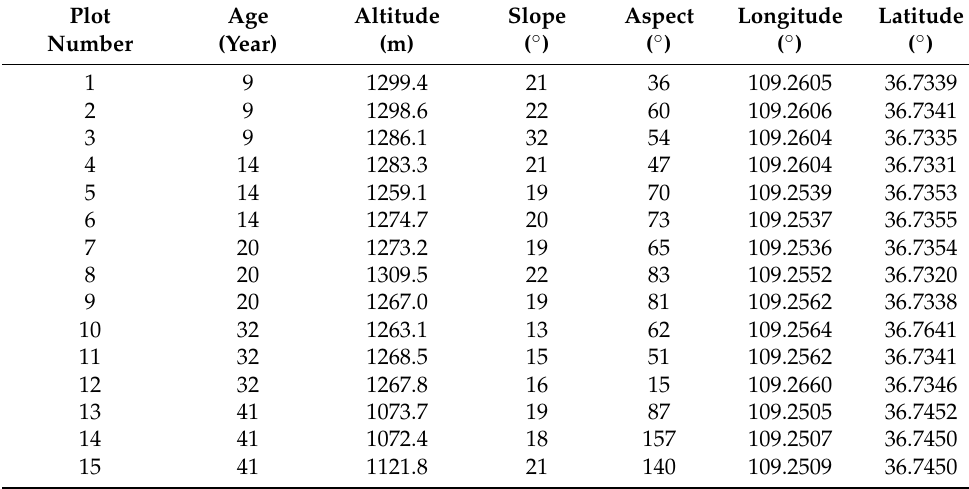
Table 1. Geographical characteristic of the sample